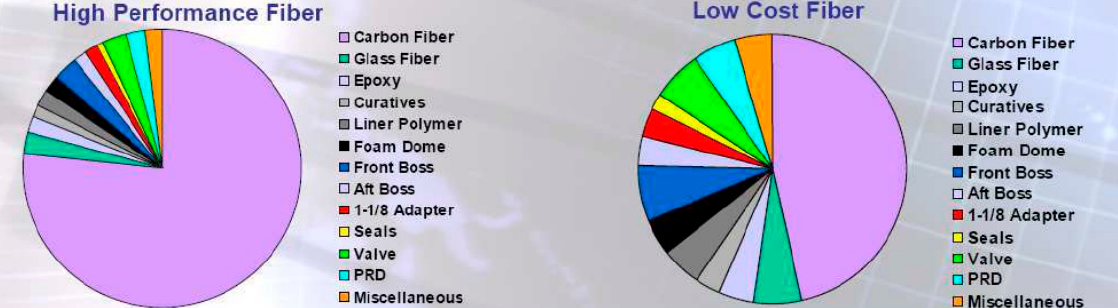
Figure 10. Costs of repartition of hydrogen high-pressure type IV vessels depending on carbon fiber types T1000/T700 (Quantum, USA) [69].